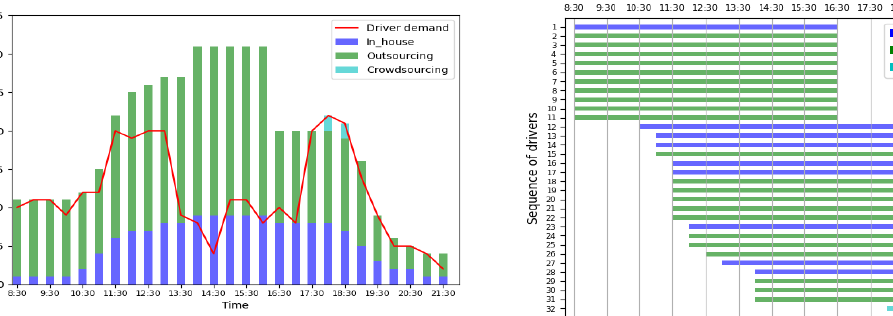
Fig. 7. Relationship between drivers' demand and the scheduling of drivers